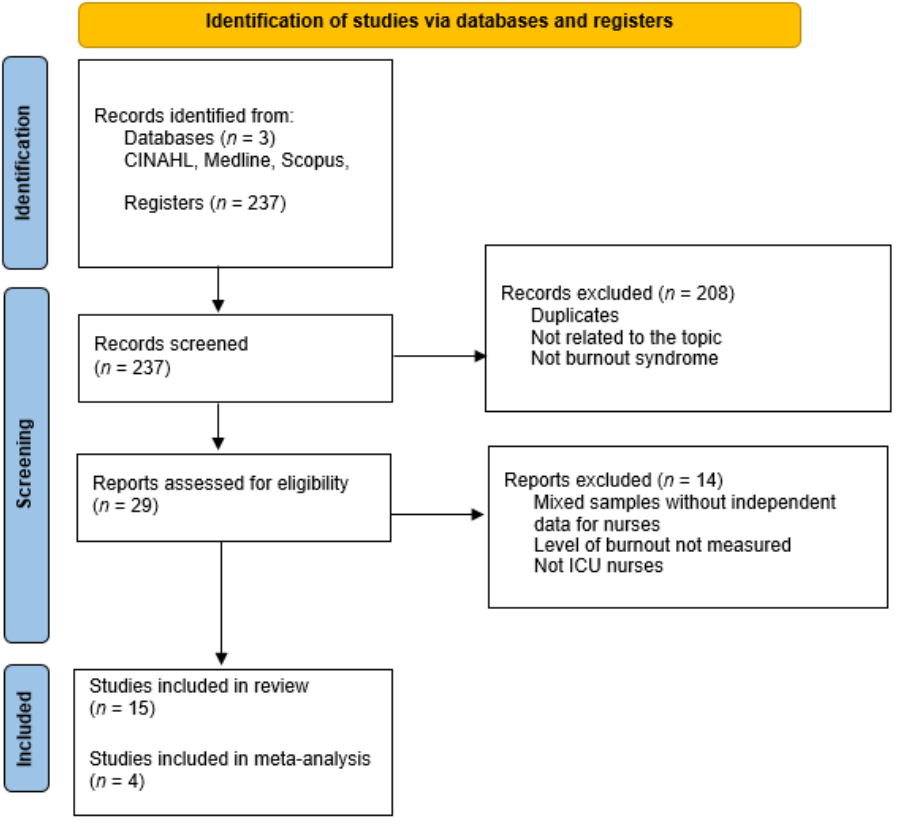
Figure 1. Flow diagram of the publication search process.